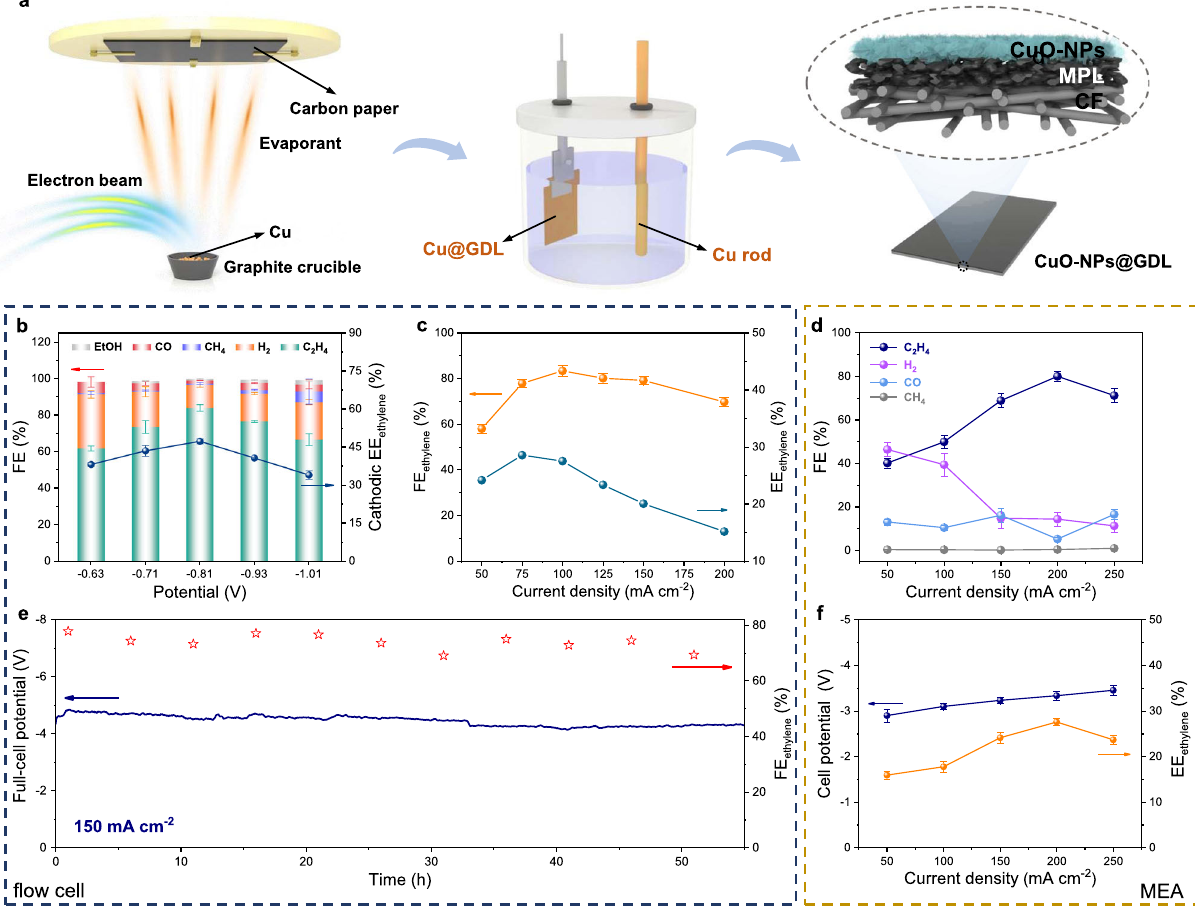
Fig. 5 Preparation and CO 2 RR performance of DVL-Cu@GDL in the fl ow cell and MEA electrolyzer. a Schematic illustration of the fabrication of CuO- NPs@GDL. (MPL: microporous layer; CF: carbon fi ber) b FEs and cathodic EE of the DVL-Cu@GDL catalyst in the fl ow cell. c Full-cell potential and C 2 H 4 cathodic EE C of the DVL-Cu@GDL catalyst in the fl ow cell. d Gas product FEs of the DVL-Cu@GDL catalyst in an MEA electrolyzer. e Stability test of the 2 H 4 DVL-Cu catalyst at a constant current density of 150 mA cm − 2 in the fl ow cell. f Cell potential and EE of the DVL-Cu@GDL catalyst in an MEA C 2 H 4 electrolyzer. Error bars represent the standard deviation of three independent